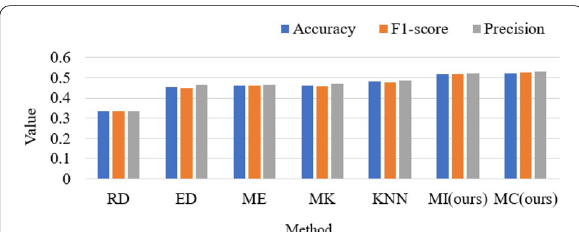
Fig. 6 The performance of the proposed model with different kinds of adjacency matrix. RD represents the random, ED represents the Euclidean distance, ME represents Mut_Euclidean, MK denotes the Mut_KNN, MI denotes Mutual Information and MC denotes Mutual_